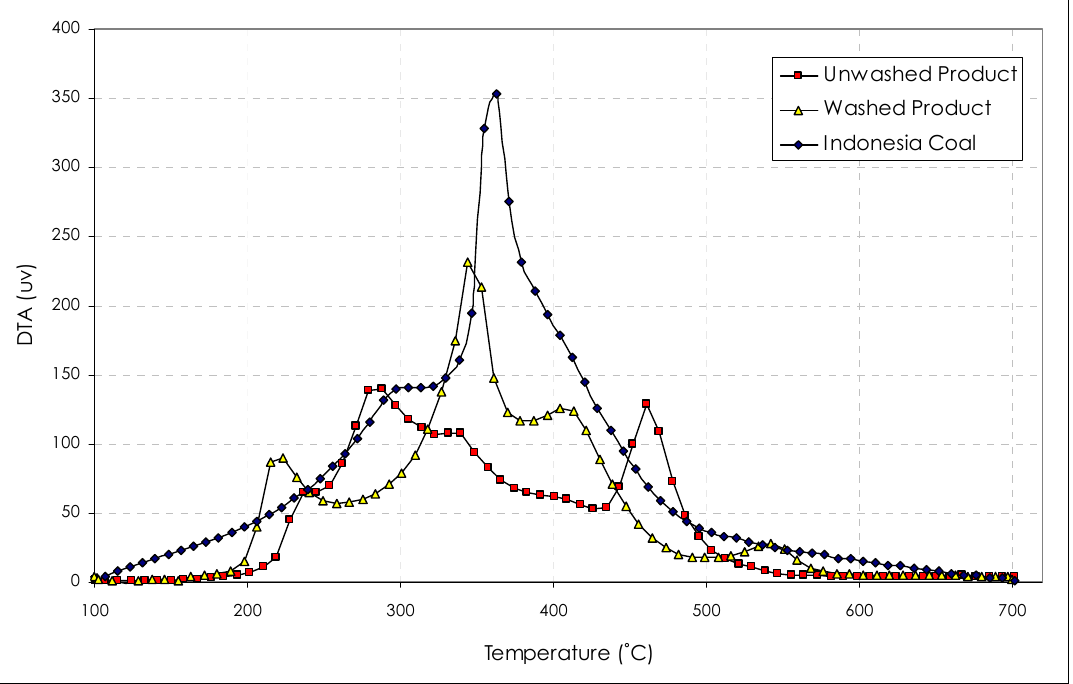
Figure 12. DTA profiles of the hydrothermal products before and after the washing